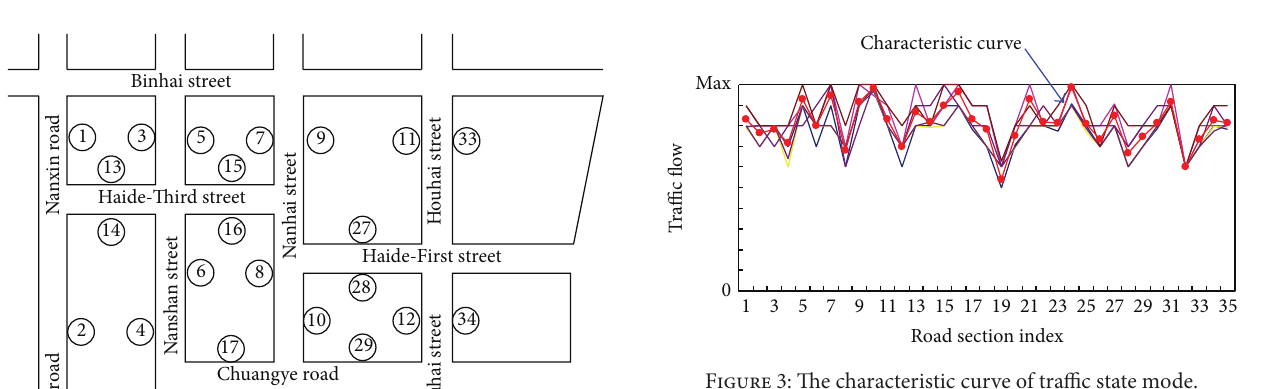
serves as a clustering algorithm as well as a dimensionality- reduction technique when applied to cluster the traffic flow vectors. After the SOM was trained, 64 clusters were obtained. Each cluster represents a traffic state pattern with 35 dimen- sions. Through fitting all the traffic state curves within each pattern using mean fitting method, we get the characteristic curve of each traffic state pattern, as shown in Figure 3. The distribution diagram of all traffic state patterns is shown in the SOM topological grid in Figure 4 and each pattern is dyed by a special color and has a unique char- acteristic curve. It could be observed that adjacent clusters represent similar patterns and each pattern changes gradually along the SOM grid. Four pattern groups A, B, C, and D are shown in this figure, respectively. For pattern group A of “blue clusters,” all links have very large flow rates and even traffic distribution. For pattern group B of “pink clusters,” the flow rates are a little lower and less evenly distributed among the links, compared to the “blue clusters” of area A. For pattern group C of “yellow clusters,” the links have moderate flow rates and uneven traffic distribution, with several links in some clusters having high flow rates in spite of the low flow rates in other links. For pattern group D of “green clusters,” the links have small flow rates and even traffic